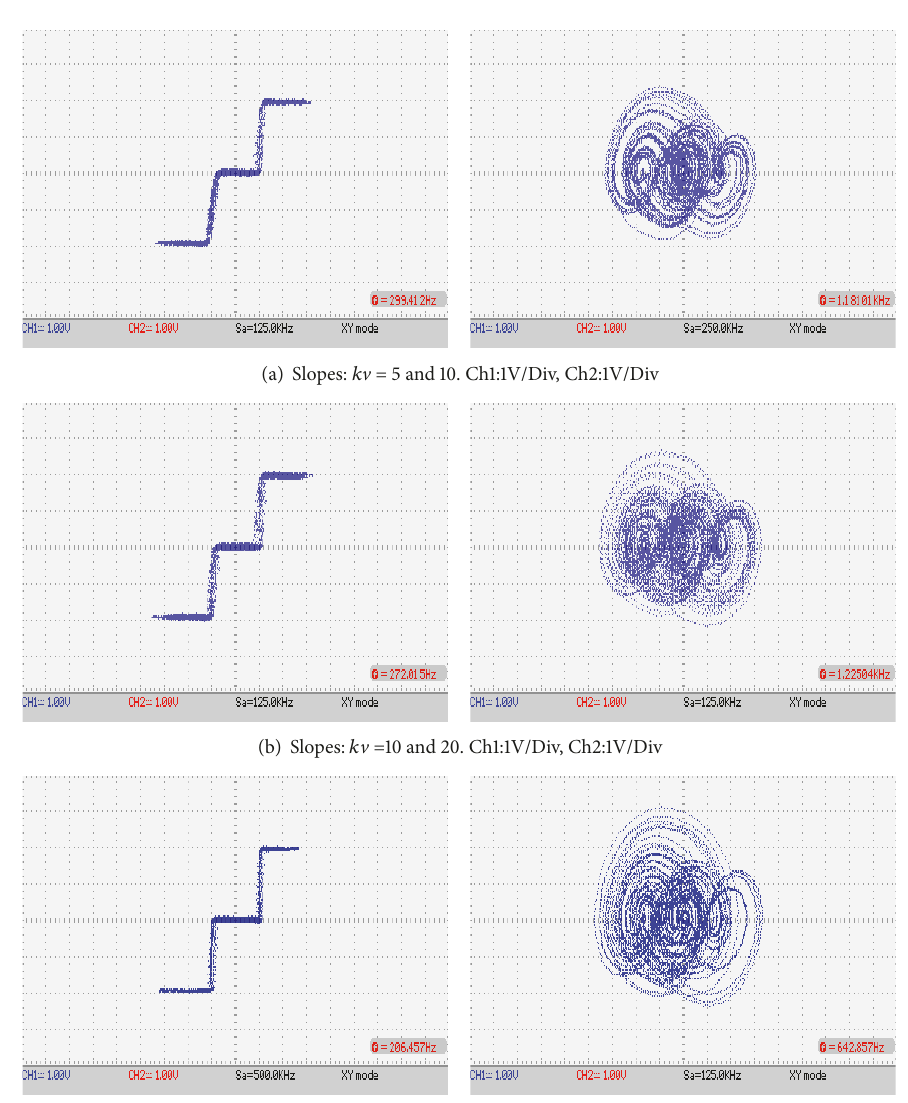
Figure 6: Experimental verification of optimized 3 scrolls using irregular SNLFs with different slopes given in Table